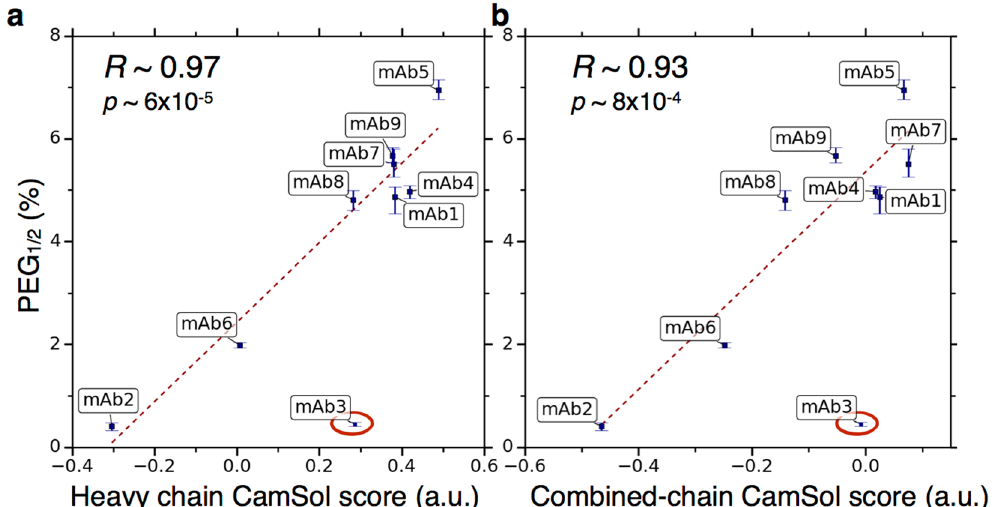
Figure 4. Correlation between the measured solubility and corresponding sequence-based computationally predicted value. Scatter plots of the observed PEG 1/2 as a function of the intrinsic CamSol solubility score. Panel ( a ) reports the CamSol scores of the VH domain only, as most mutations are found here (see Figure 2). Panel ( b ) reports a combined score reflecting both VH and VL-domain contributions (see Methods). Regression lines, reported Pearson’s coefficients of correlation ( R ) and corresponding p-values ( p ) have been calculated by excluding the outlier point circled in red